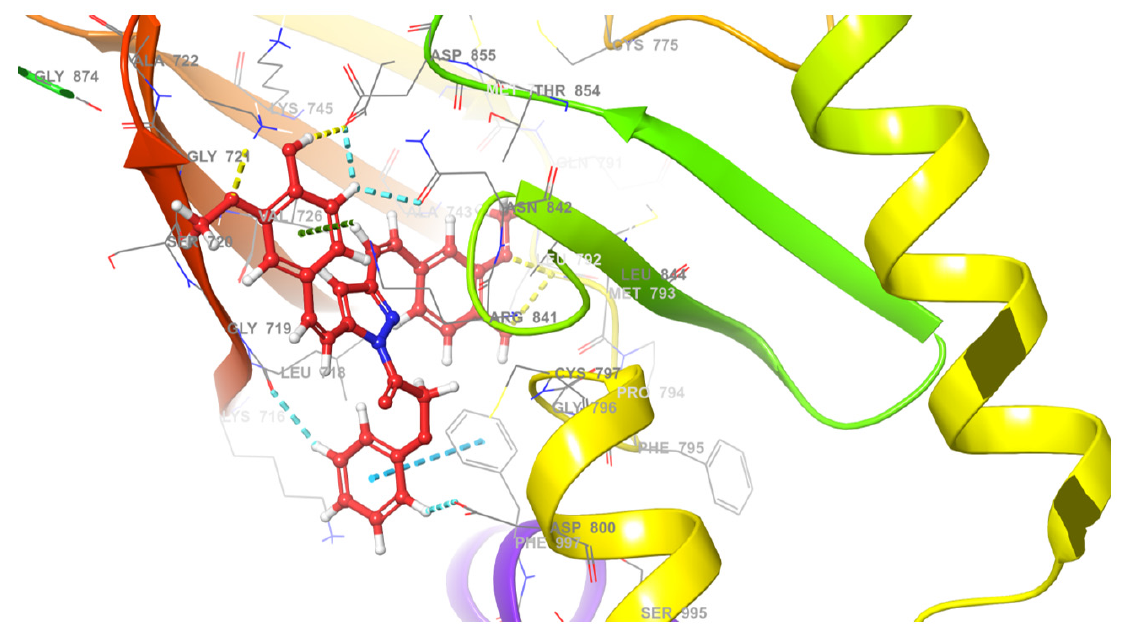
Figure 5. The 3D interactions of ligand 3b against the active site of EGFR .